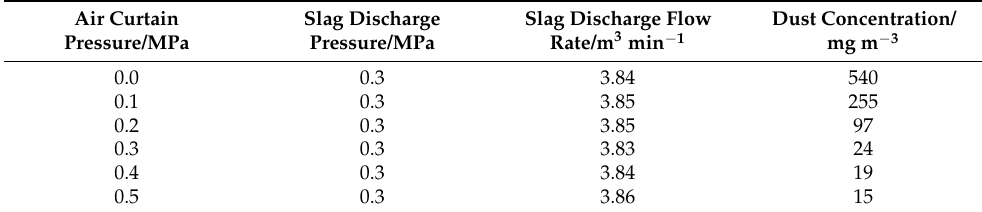
Table 5. Dust control effect with the slag discharge pressure at 0.3